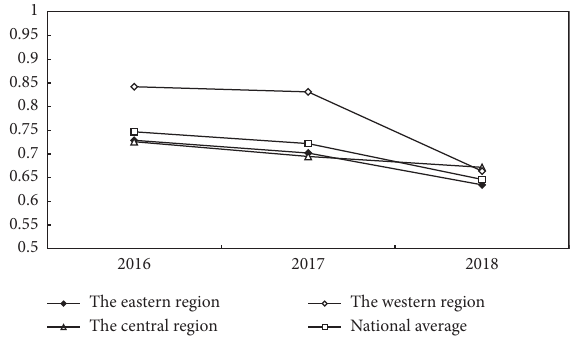
Figure 5: Environmental output efficiency of green innovation of listed energy companies in China from 2016 to 2018.